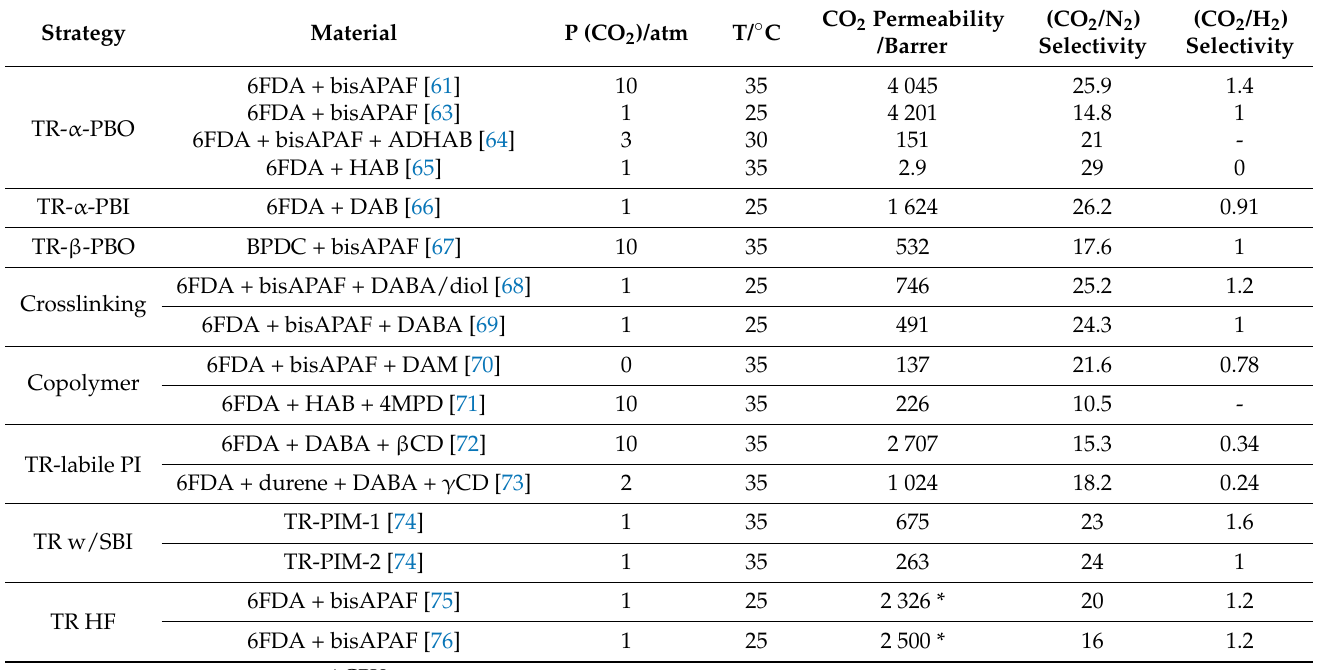
Figure 3. Thermal rearrangement of (1) TR- α , where the ancestor is an ortho-functional polyimide (PI), and (2) TR- β , where the ancestor is an ortho-functional polyamide (PA) [62]. Table 5. The transport properties of various selected TR